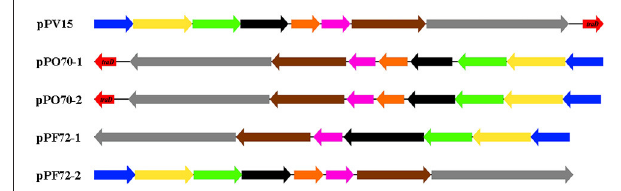
FIGURE 1 | Genetic arrangement of the shared conjugation region of plasmids pPF72-1, pPF2-2, pPO70-1, pPO70-2 and pPV15. Predicted conjugation genes and their orientation are presented in block arrows. The different genes are represented in colors: virB9 (blue), type VI secretion system (T6SS) protein-encoding gene (yellow), virB11 (green), lytic transglycosylase protein encoding gene (black), hypothetical protein encoding gene (orange), endonuclease protein encoding gene (pink), trwB (brown), relaxase protein encoding gene (gray), traD (red). Difference in orientation of the conjugation regions amongst the plasmids are represented by the direction of the block arrows. Block arrows pointing toward the left indicate reverse strand orientation whereas block arrows pointing toward the right indicate forward strand